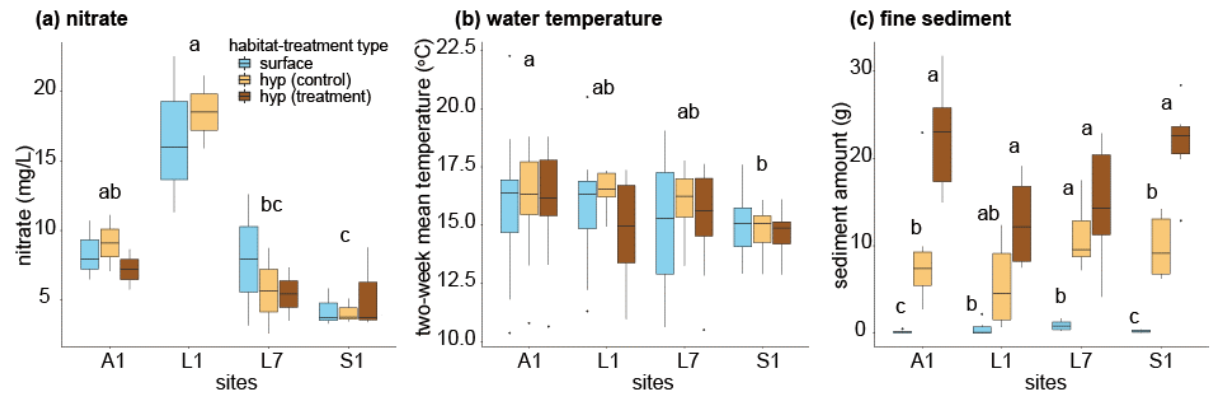
Figure 2. Comparisons of nitrate ( a ), water temperature ( b ), and fine sediment ( c ) in relation to habitat-treatment types.